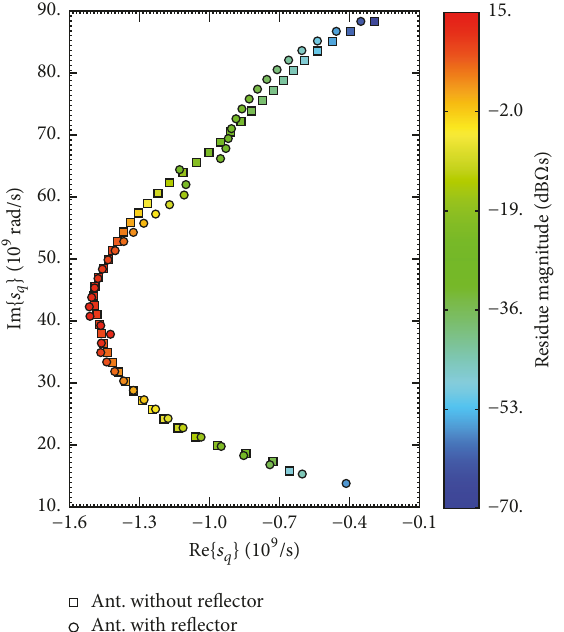
Figure 14: Location, in the complex 𝑠 -plane, of the SEM-based dominant poles of the time-domain response of the drop-shaped antenna with and without reflector. The magnitude of the residues associated with each pole is marked with a specific colour. For the sake of clarity only the poles distributed in the second quadrant of the complex 𝑠 -plane are reported in the figure.